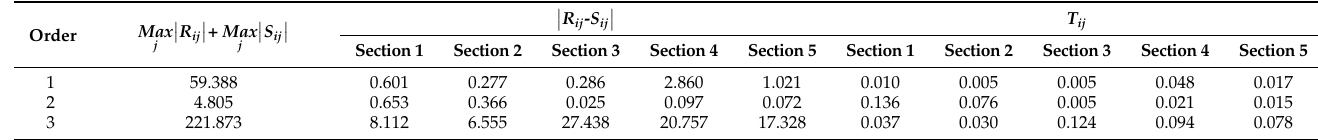
Table 7. Cross-section rotor–stator rubbing risk